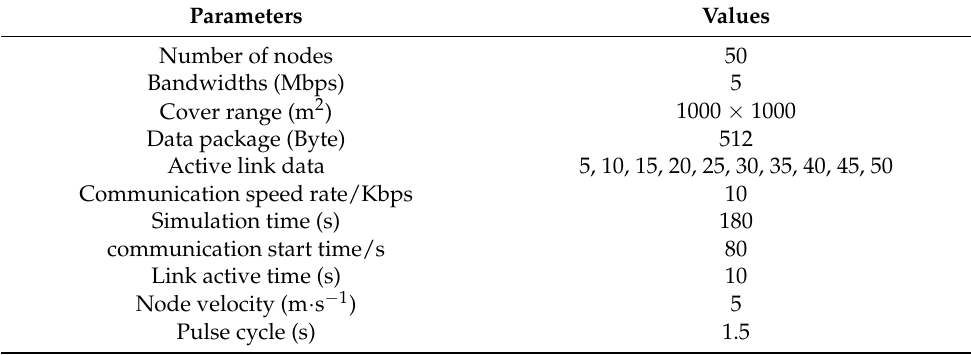
Table 1. Simulation parameters.